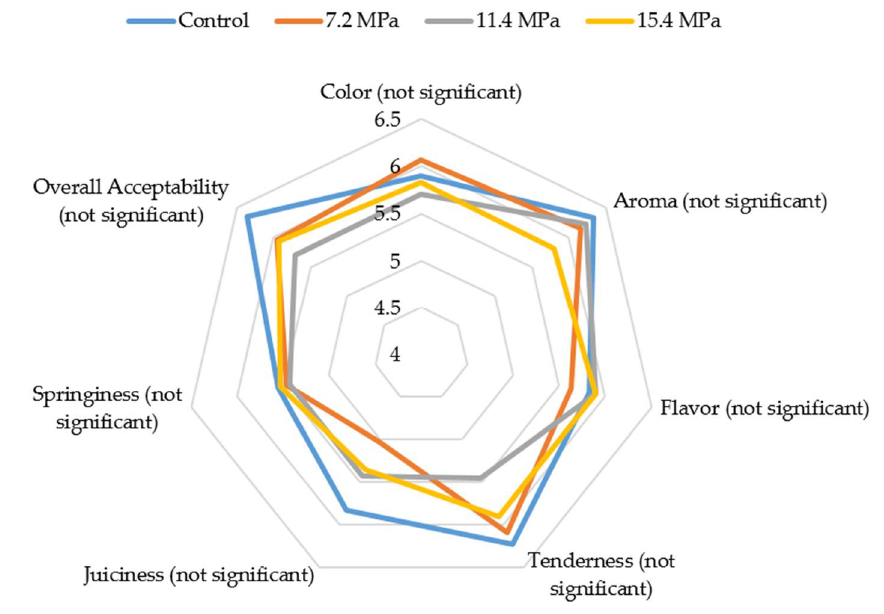
Figure 2. The e ff ects of three levels (7.4, 11.4 and 15.4 MPa) of SC-CO 2 at 31 ◦ C for 10 min on sensory Figure 2. The effects of three levels (7.4, 11.4 and 15.4 MPa) of SC-CO 2 at 31 °C for 10 min on sensory analysis of cooked chicken meat stored at 4 ± 1 ◦ C for three analysis of cooked chicken meat stored at 4 ± 1 °C for three days.